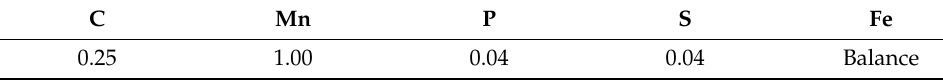
Table 1. Composition of the tested steel specimen.